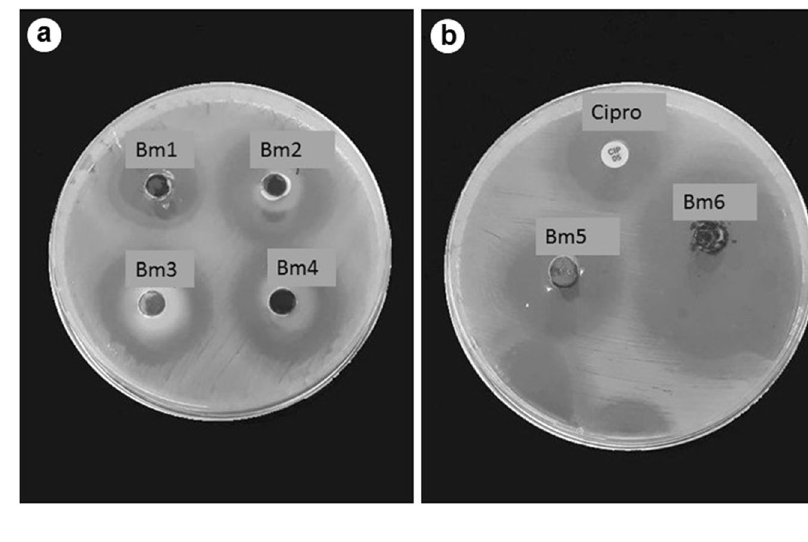
Fig. 3 Petri dishes showing the halos formed in the agar- diffusion test. Bm1: HC; Bm2: HCoFS γ 2 ; Bm3: HCoFS γ 1 ; Bm4: HCoFS γ 3 ; Bm5: JCoFS γ 1 ; Bm6: C γ ;